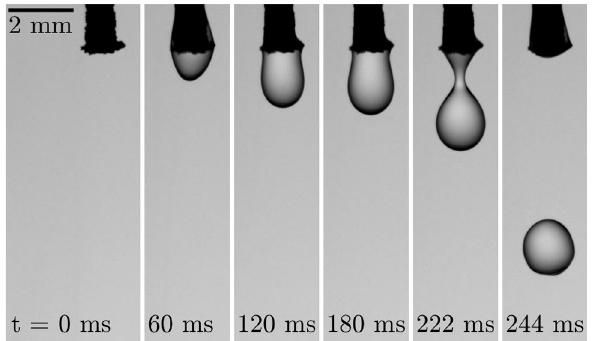
Figure 8. Droplet formation at the needle outlet for the device operated in equilibrium at p l ≈ 1.15 bar and p g ≈ 0.45 bar. Time t = 0 refers to the moment, when the first liquid is visible to leave the needle after over- pressurizing the outer tube for approximately 50 ms.